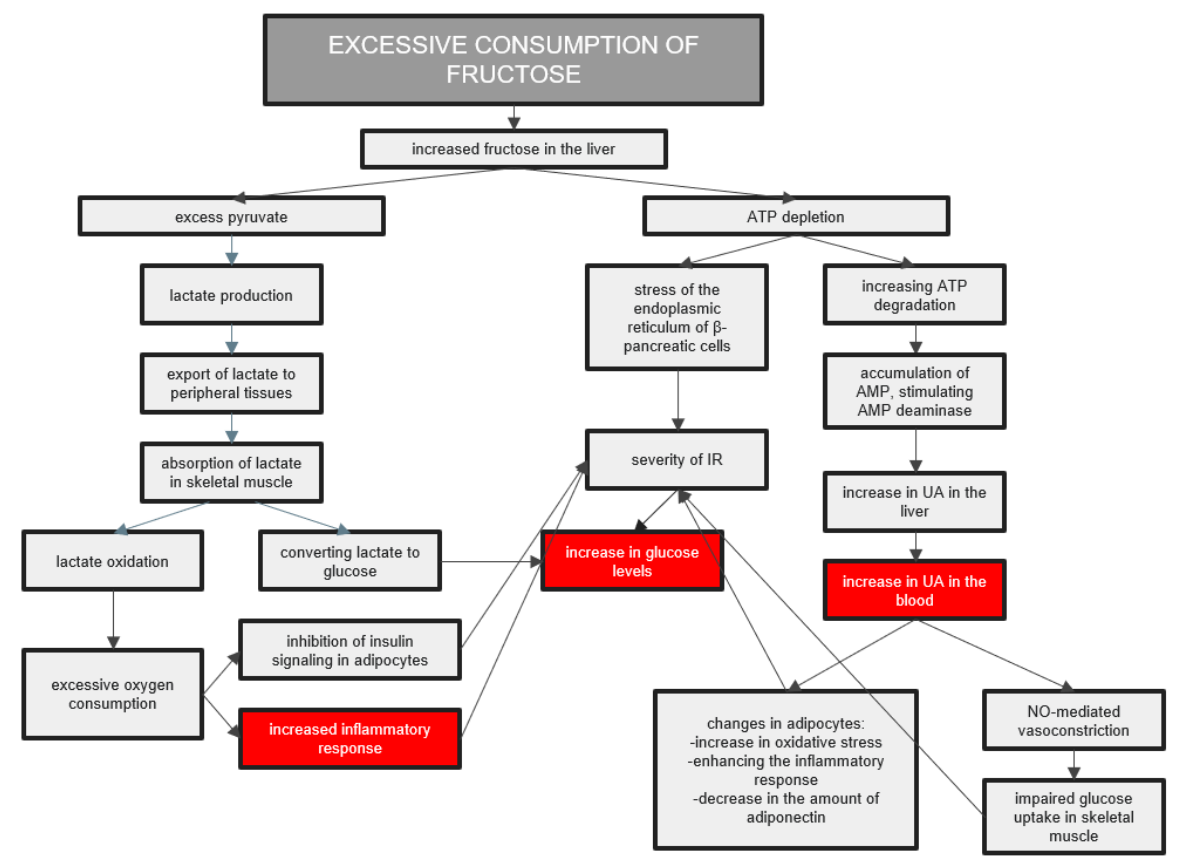
Figure 2. The body’s reactions to excessive fructose consumption. The increased amount of fructose in the liver leads to an inflammatory reaction in the body, increasing glucose and uric acid levels in the blood. Abbreviations: IR — insulin resistance; UA — uric acid.